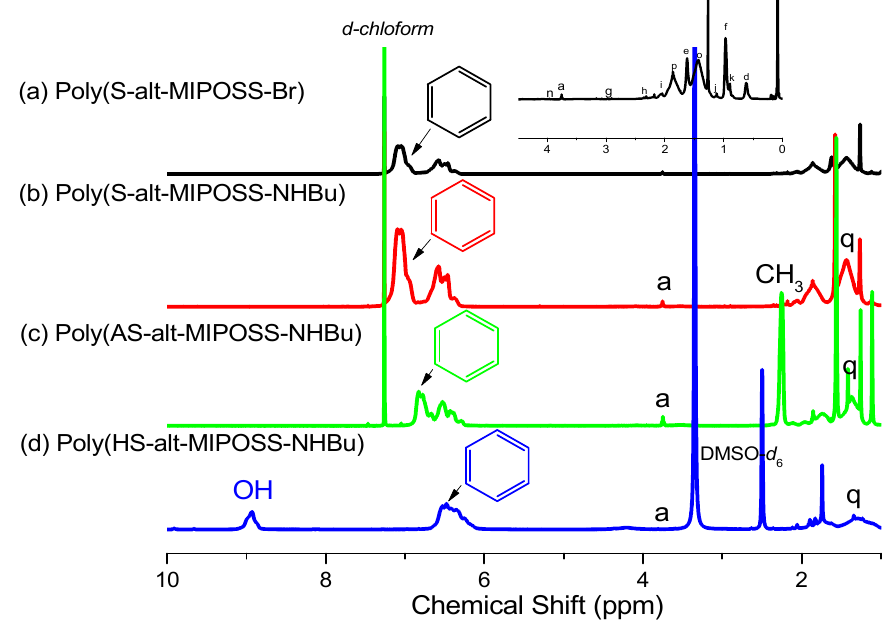
Figure 4. 1 H-NMR spectra of: ( a ) poly(S- alt -MIPOSS-Br); ( b ) poly(S- alt -MIPOSS-NHBu); ( c ) poly(AS- alt -MIPOSS-NHBu); and ( d ) poly(HS- alt